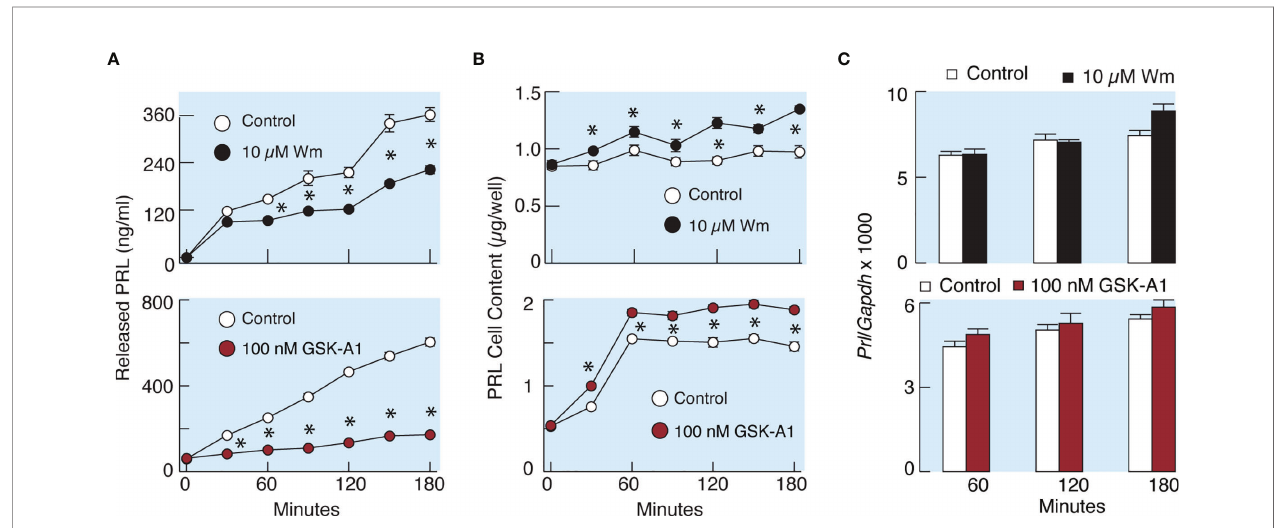
FIGURE 6 | Wm and GSK-A1 induced inhibition of PRL release are not caused by loss of intracellular PRL content and inhibition of PRL gene ( Prl ) expression. (A) Time course of Wm- (top) and GSK-A1 (bottom) induced inhibition of basal PRL release. (B) Time course of Wm (top) and GSK-A1 (bottom) induced accumulation of intracellular PRL content. (C) Lack of effects of Wm (top) and GSK-A1 (bottom) on Prl expression in cultured anterior pituitary cells. The experiments were performed in static incubation of cultured anterior pituitary cells: 0.25 million/well (A, B) and 1.5. million/well (C) . Data points shown are mean ± SEM of sextuplicate incubation; *P < 0.002 between